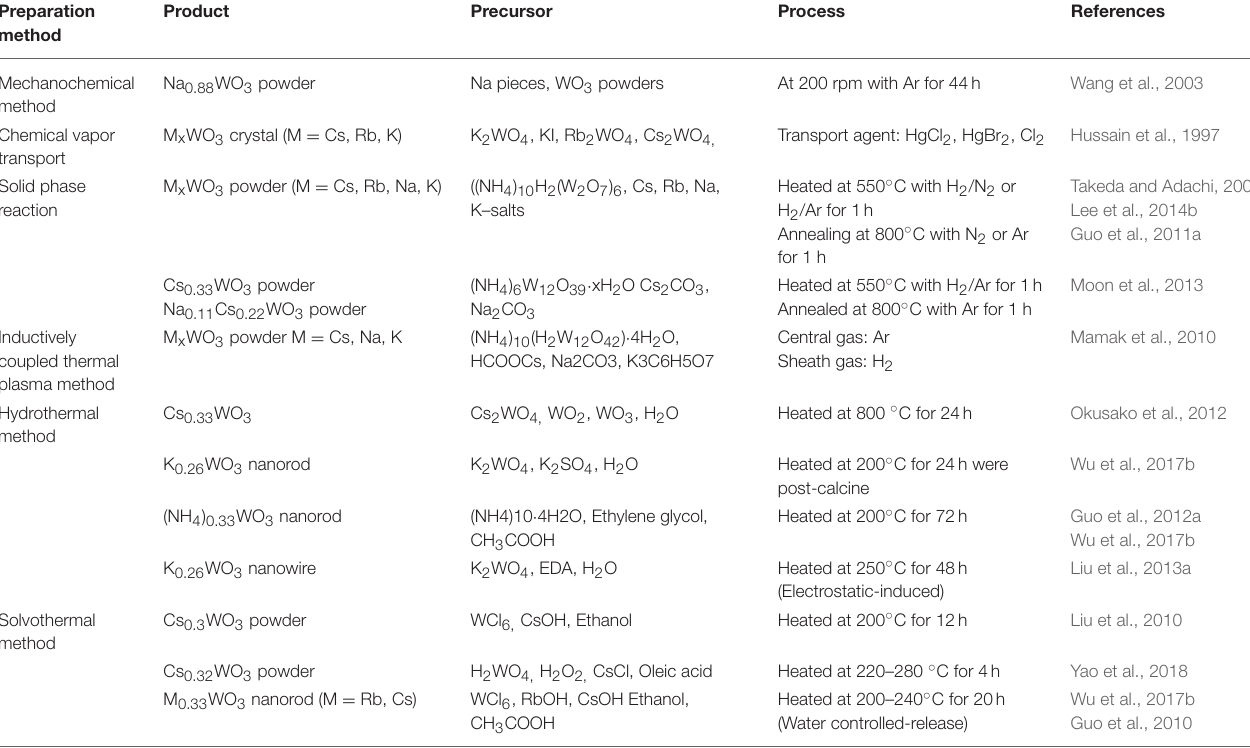
TABLE 1 | List of the preparation methods for tungsten bronze (M x WO 3